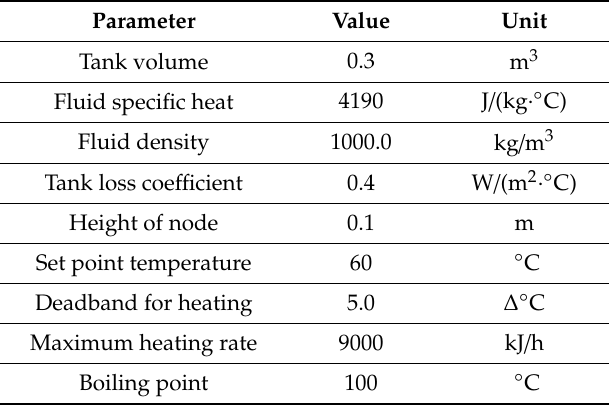
Table A2. Depiction of the water storage tanks.